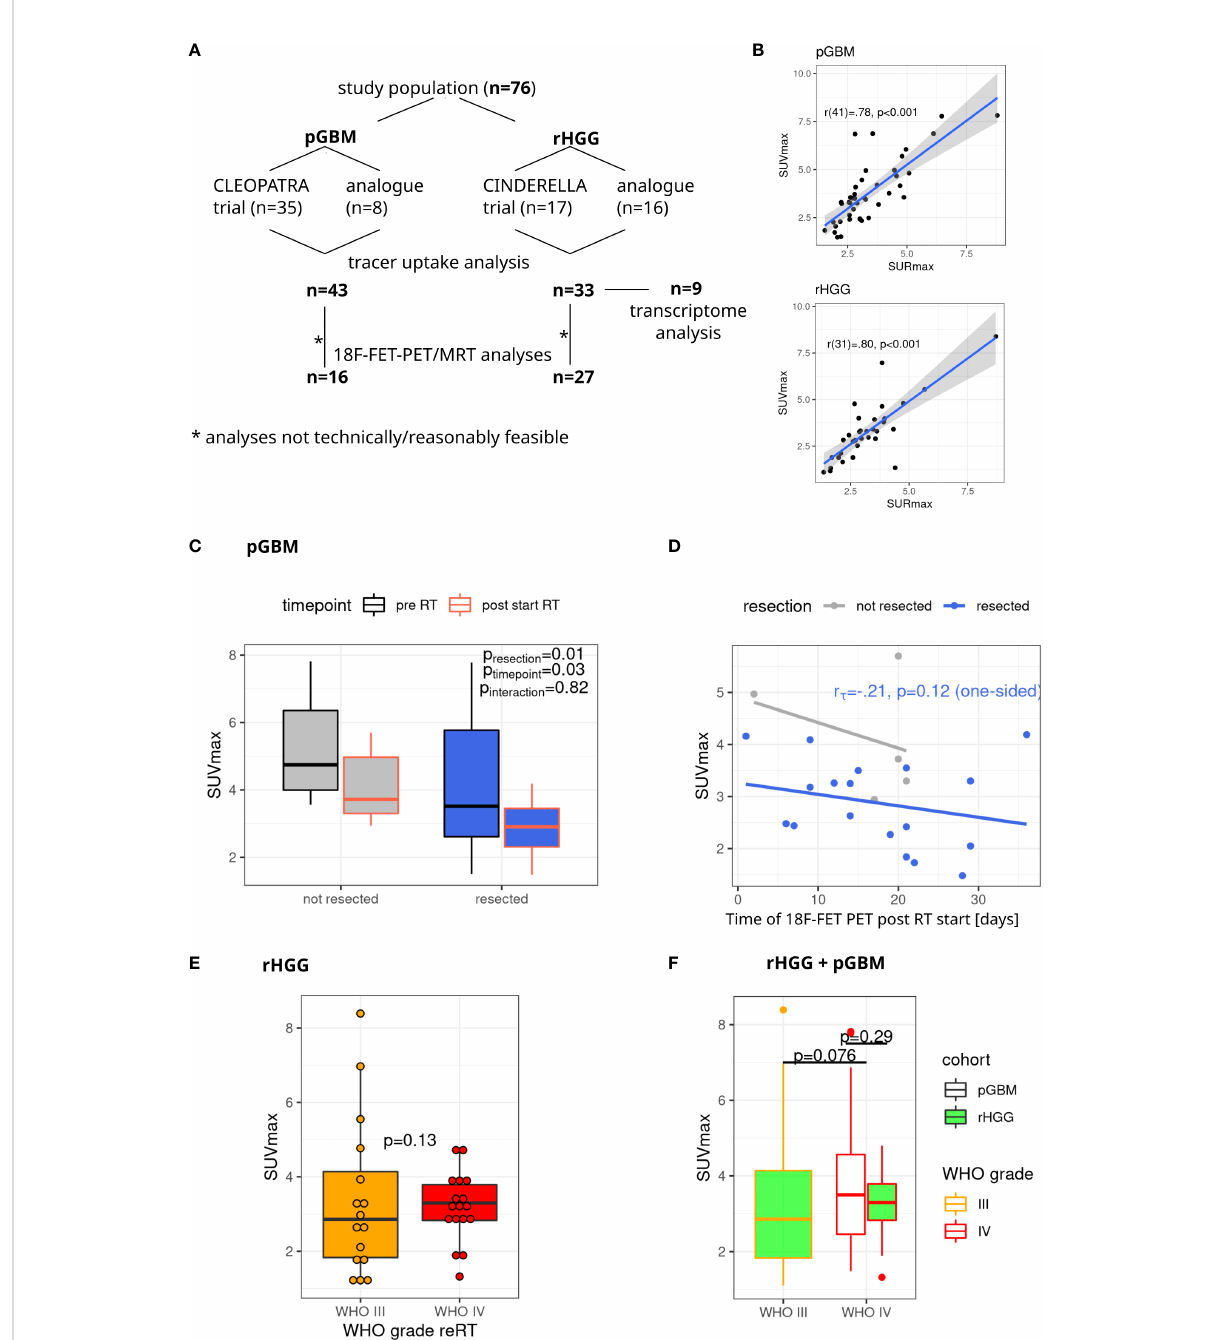
FIGURE 1 Study cohort and tracer uptake in pGBM and rHGG. (A) Overview of the study cohort. (B) A strong correlation (r = 0.80) is observed between SUVmax and SURmax values (Pearson ’ s correlation). (C) SUVmax in pGBM depending on resection status and time point after RT start. Non- parametric model analysis (rankFD). (D) SUVmax values after irradiation start. Linear model fi t, Kendall ’ s tau for resected samples (one-sided p- value). (E) SUVmax in rHGG, one-sided p-value, robust p-value (robustbase). (F) SUVmax in grade III and IV tumors. One-sided robust p-value (robustbase). pGBM, primary glioblastoma; rHGG, recurrent high-grade glioma; RT,